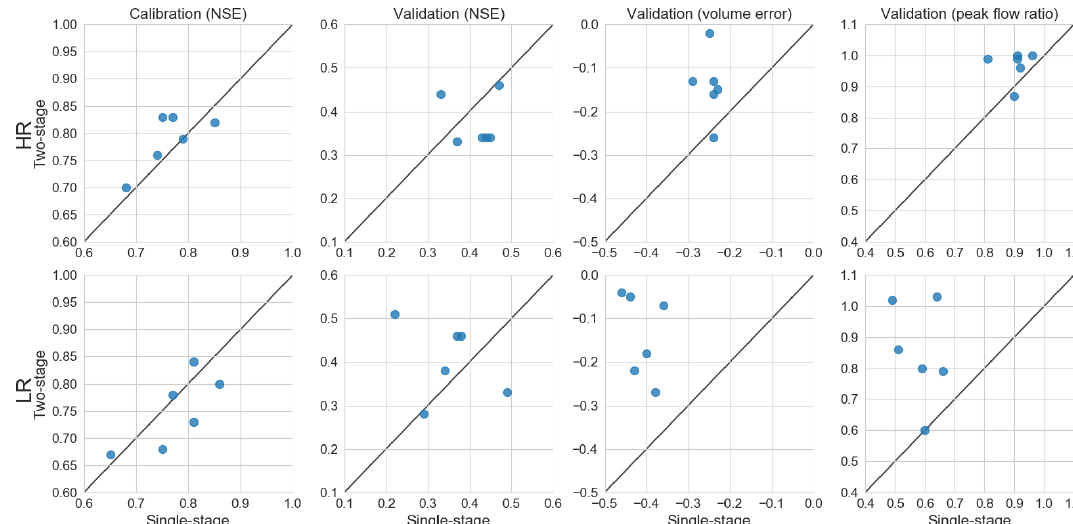
Figure 6. Comparison of single-stage and two-stage calibration